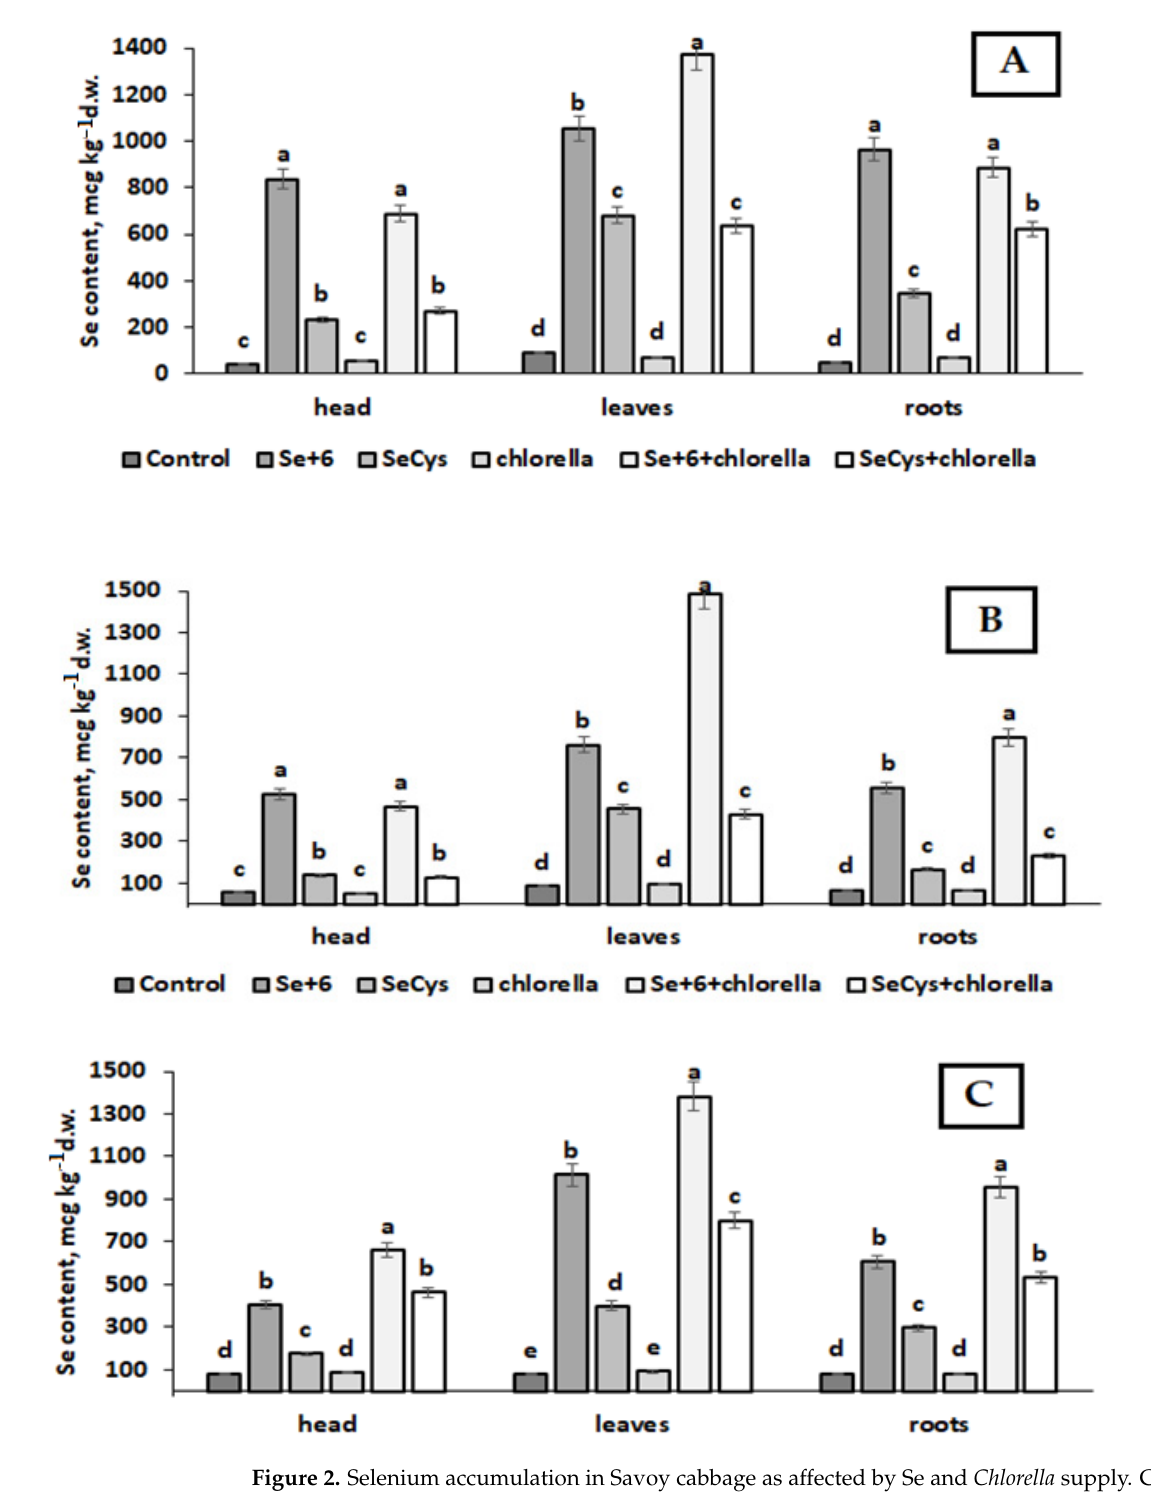
Figure 2. Selenium accumulation in Savoy cabbage as affected by Se and Chlorella supply. Cultivars: ( A )—Vertu 1340; ( B )—Golubtsy; ( C )—Melissa. Values with the same letters do not differ statistically according to the Duncan test at p < 0.05.